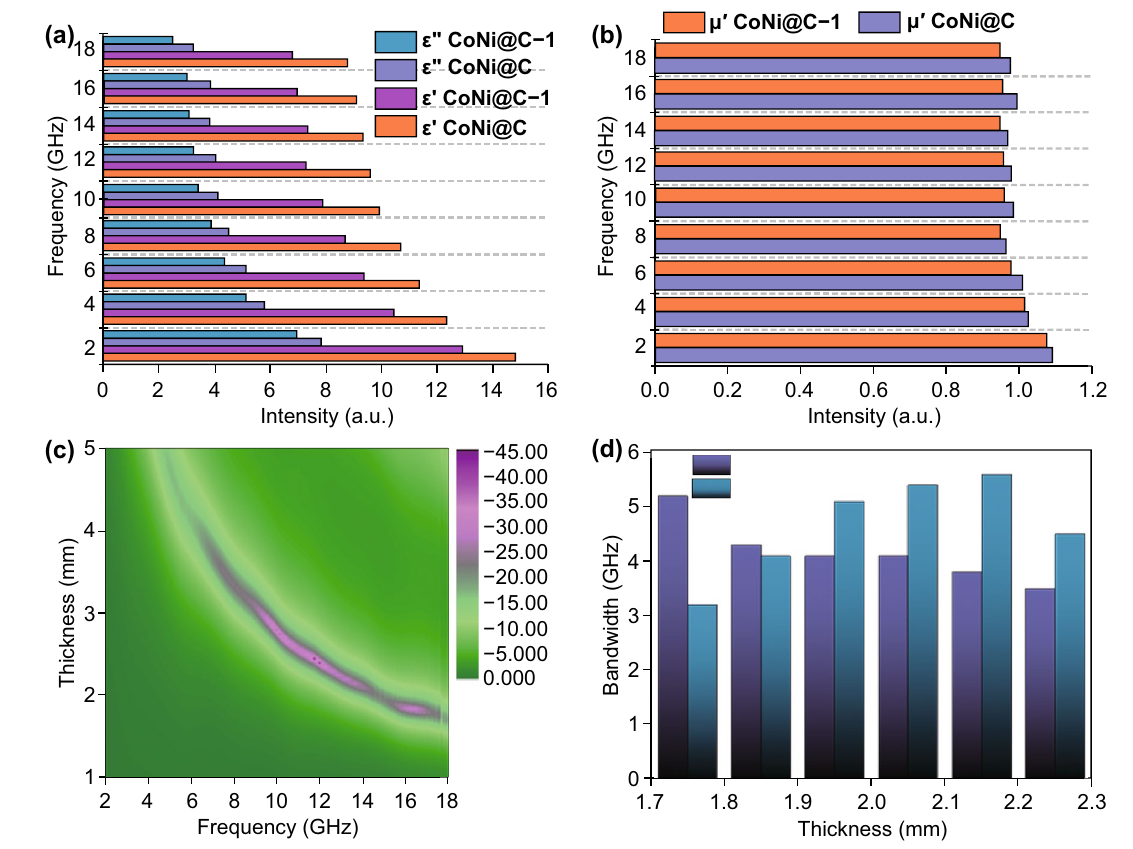
Fig. 5 a Permittivity and b real part of permeability of CoNi@C composites and after 1 year of exposure in air. c RL values of CoNi@C com- posites exposure in air after a year. d Effective bandwidth of CoNi@C and after a year of exposure in air with different